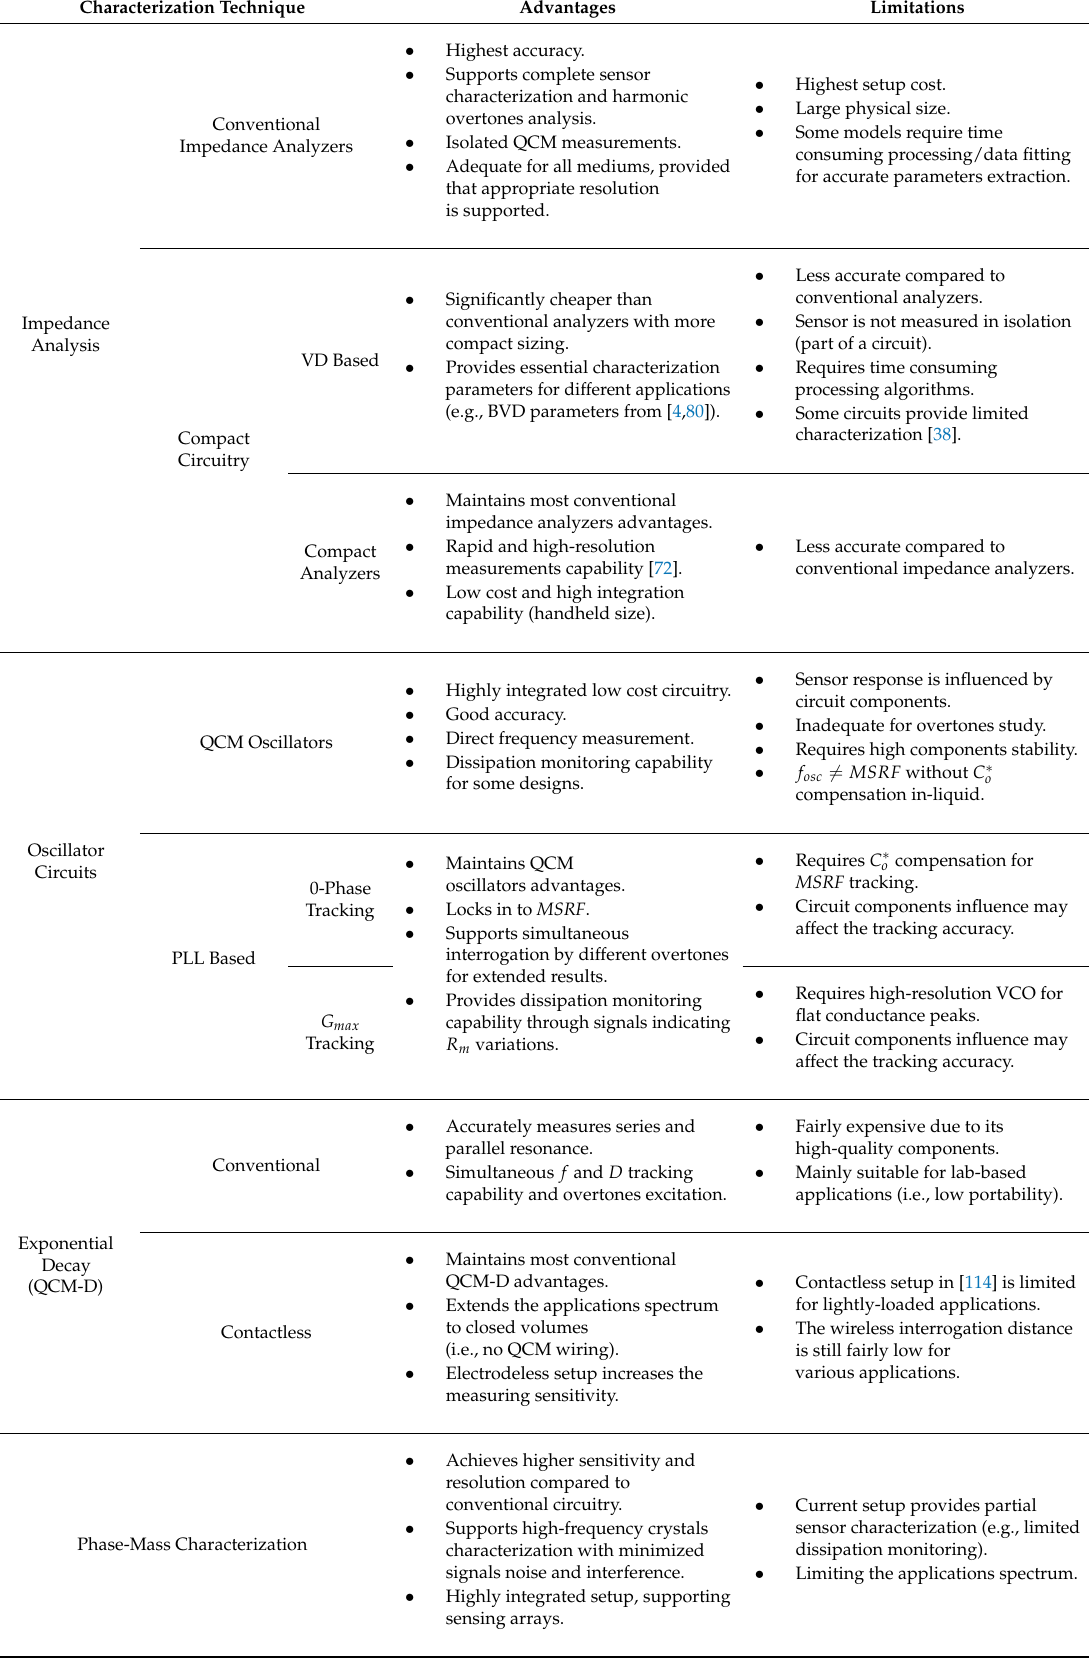
Table 1. QCM electronic characterization systems qualitative